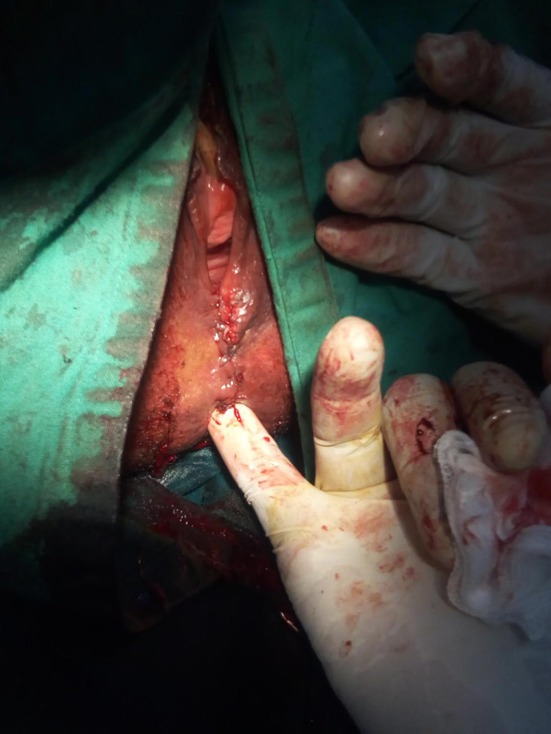
Skin over perineum closed and anal sphincter complex intact with no palpable rectovaginal fistula.